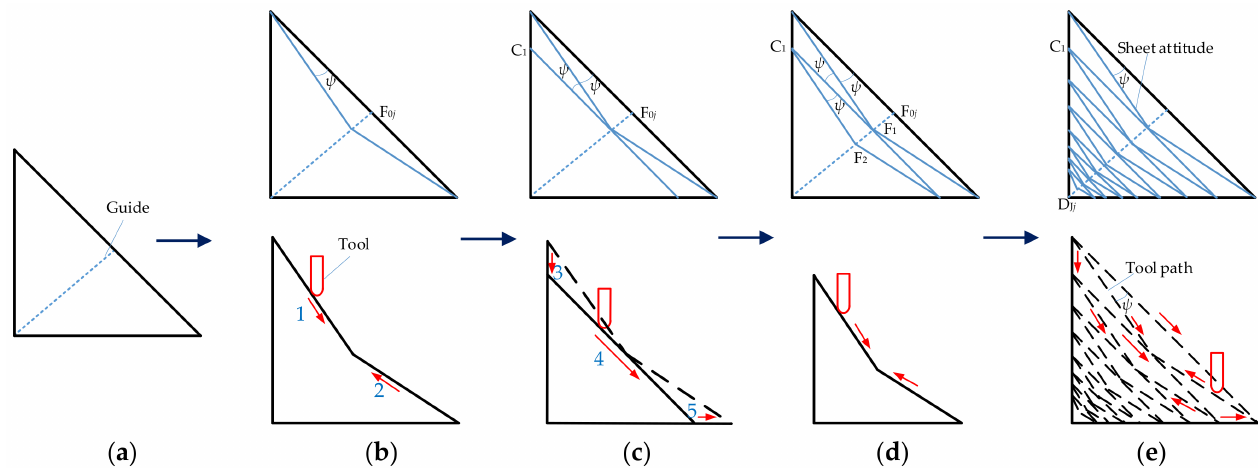
Figure 3. The second stage forming toolpath and forming tool movement planning: ( a ) the position of the auxiliary line; ( b ) the first layer; ( c ) the second layer; ( d ) the third layer; and ( e ) the second stage